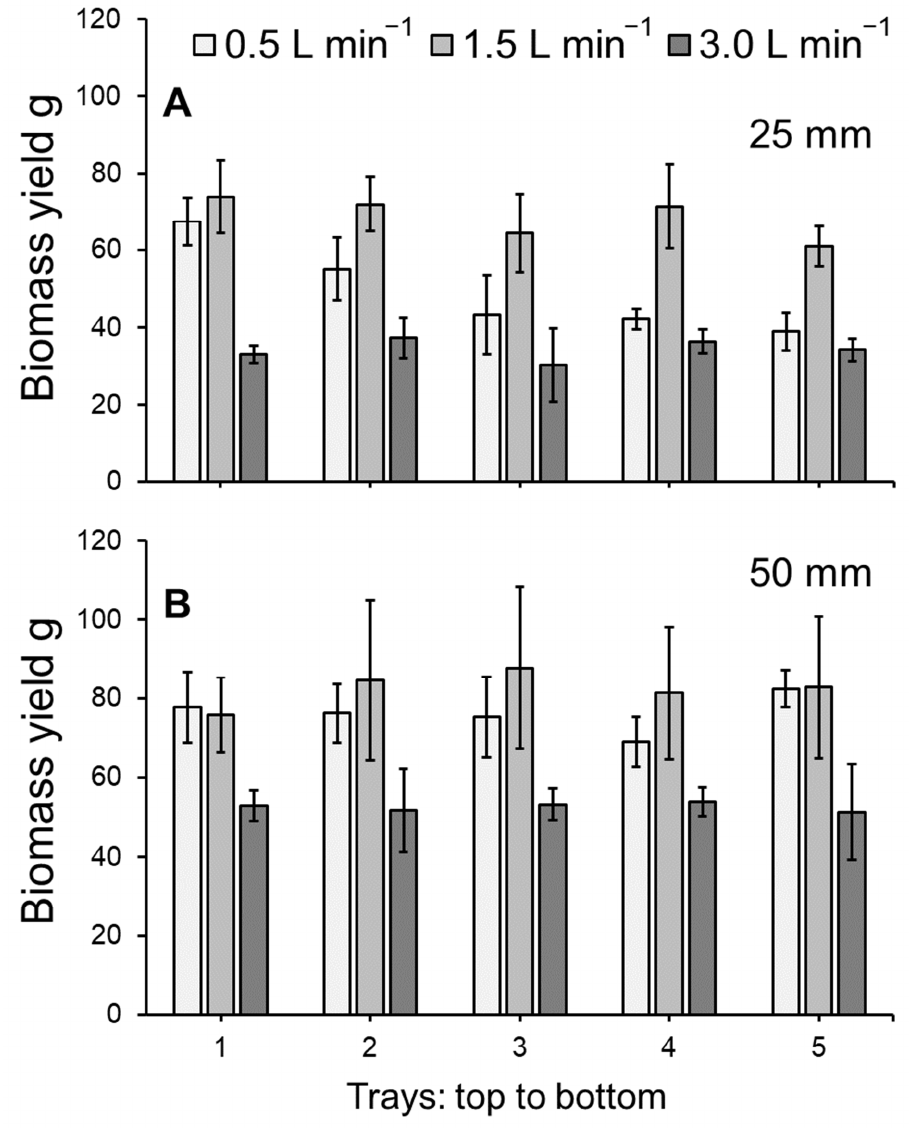
Figure 2. Mean ( ± SE) biomass yield (g) at medium depths of ( A ) 25 mm and ( B ) 50 mm for Lemna minor grown within an indoor, vertically stacked system. Plants were grown on hydroponics medium at three flow rates (0.5, 1.5 or 3.0 L min -1 ) and two medium depths (25 or 50 mm) over 7 days. See Figure 3 for a simplified model depiction with post-hoc analysis.